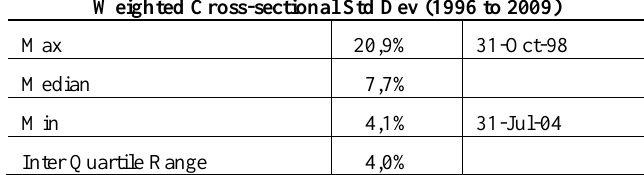
Table 1: Cross-sectional standard deviation on the J203 (FTSE JSE All Share